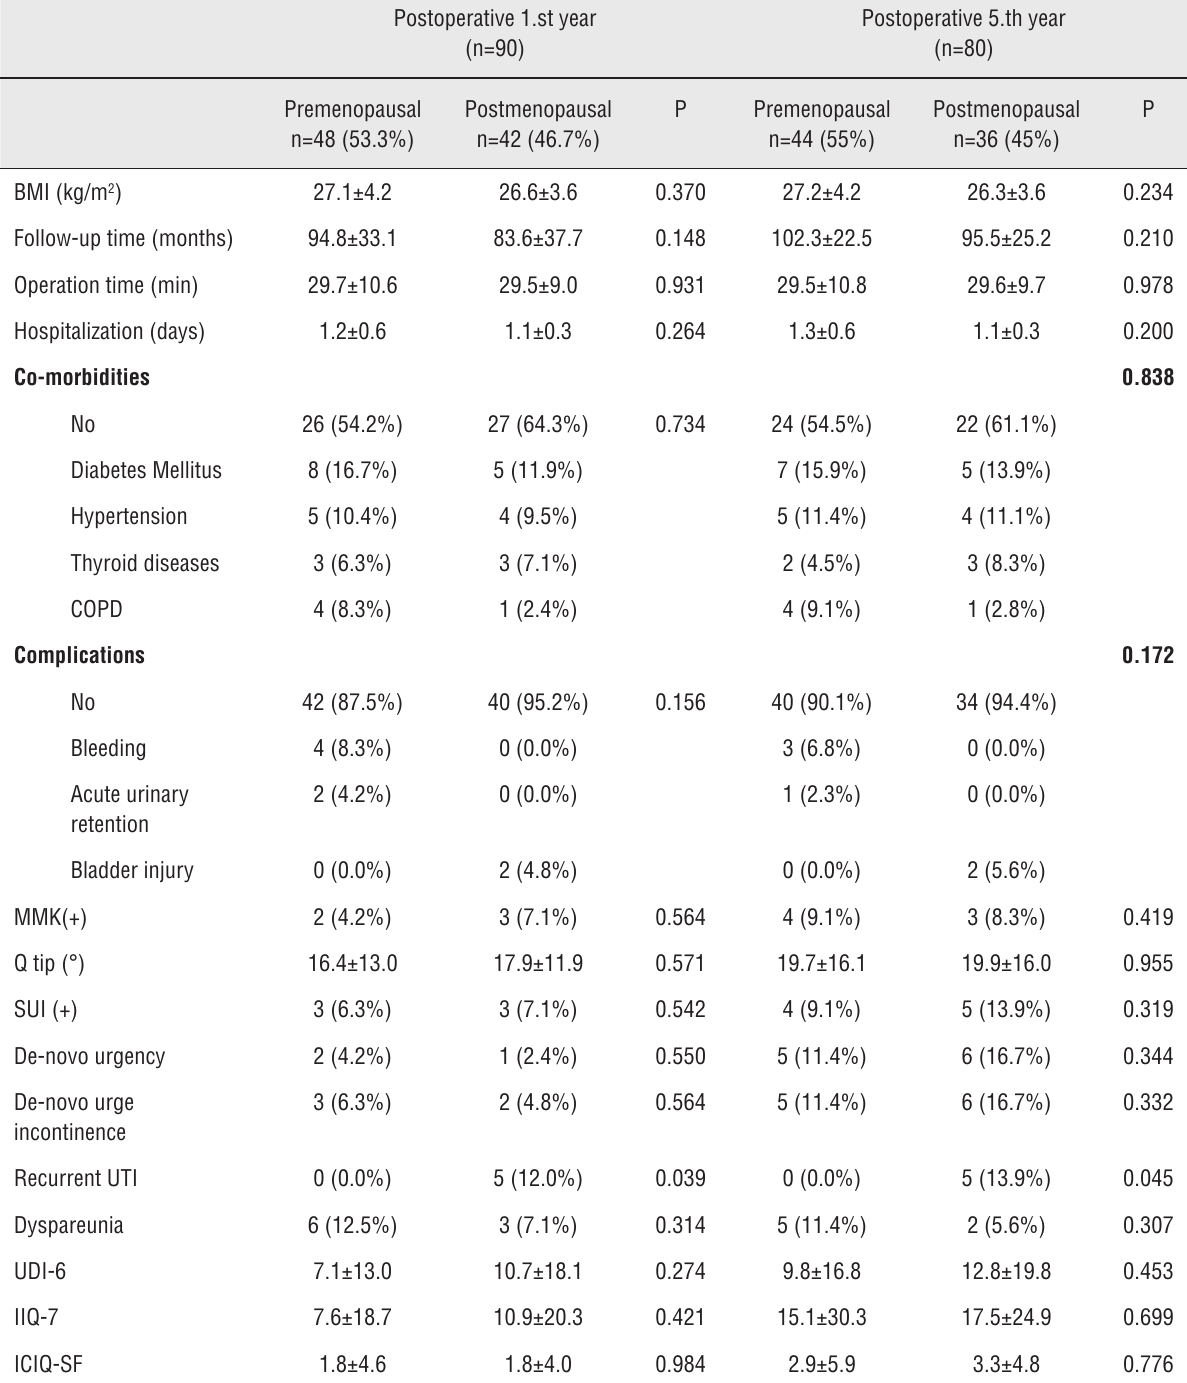
Table 3 - Comparison of the demographic characteristics, surgical outcomes and complications of the postmenopausal and premenopausal groups in terms of follow-up